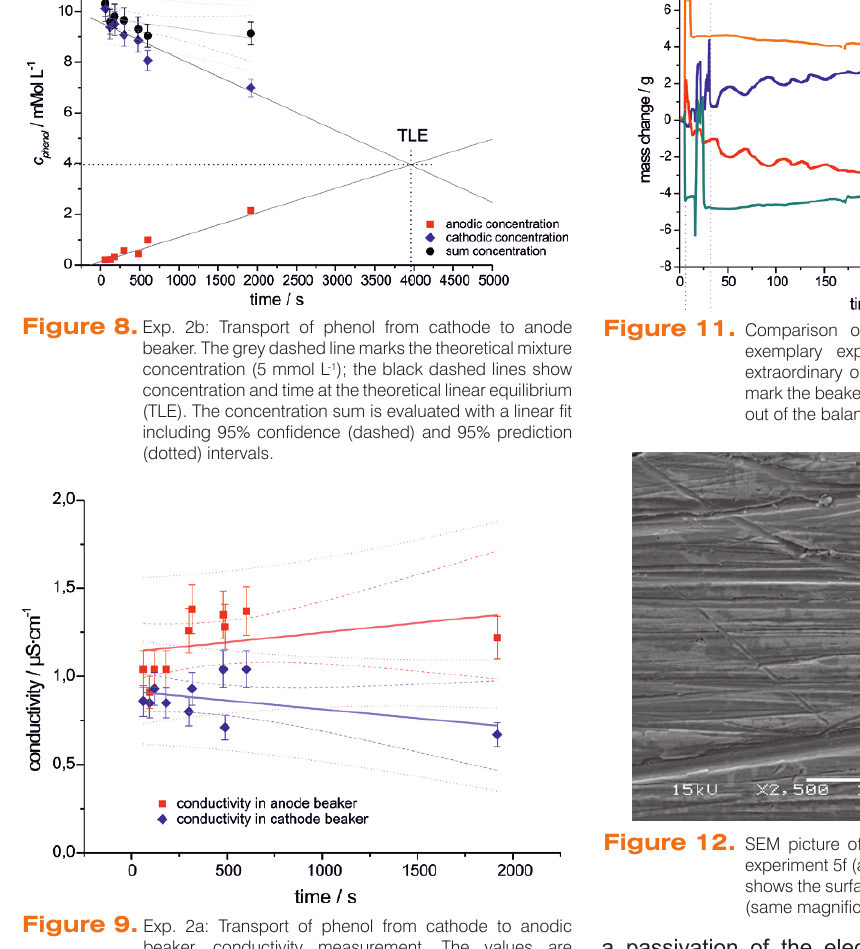
Figure 9. Exp. 2a: Transport of phenol from cathode to anodic beaker, conductivity measurement. The values are evaluated with a linear fit including 95% confidence (dashed) and 95% prediction (dotted) intervals.